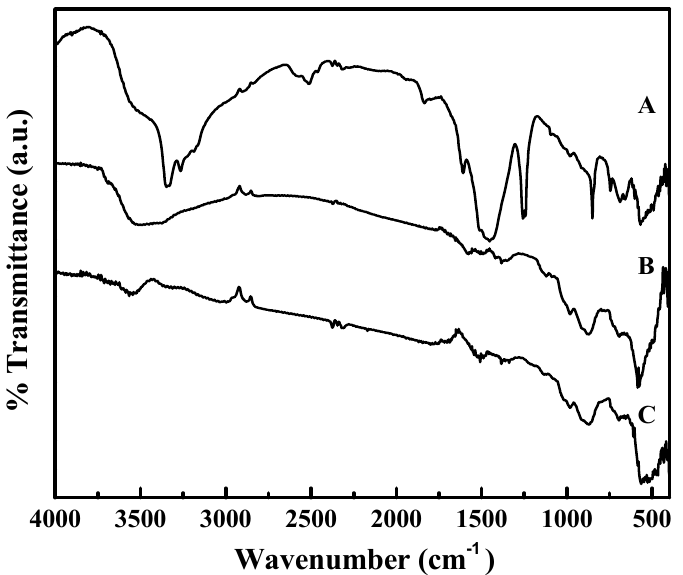
Figure 14. Comparative Fourier Transform Infrared (FTIR) signatures collected on the ZnO-based sensor film after: ( A ) exposing to 11,000 ppm ammonia for 40 min. at